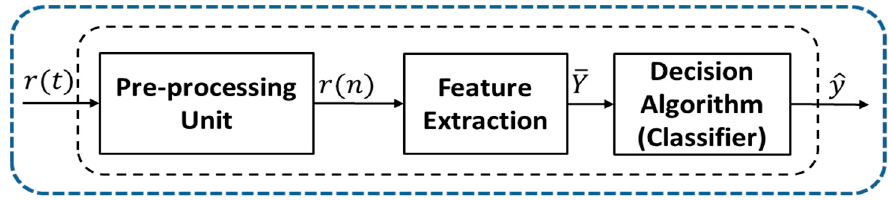
Figure 1. A simple block-wise architecture of a Feature-Based (FB) classifier.